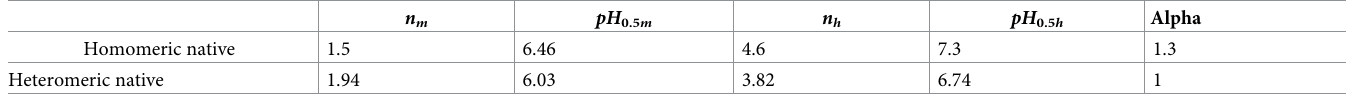
Table 1. Parameters defining the pH-dependence of the steady-state m and h variables for the native homomeric and heteromeric ASIC